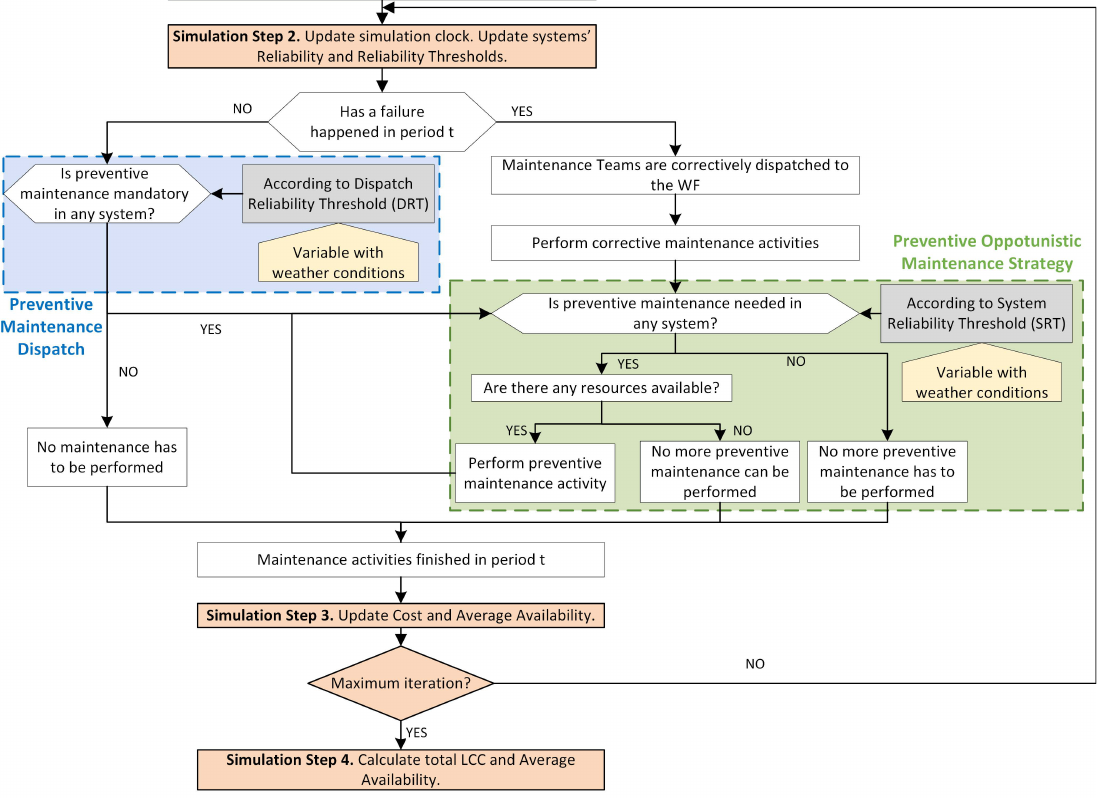
Figure 3. Dynamic Opportunistic Maintenance simulation